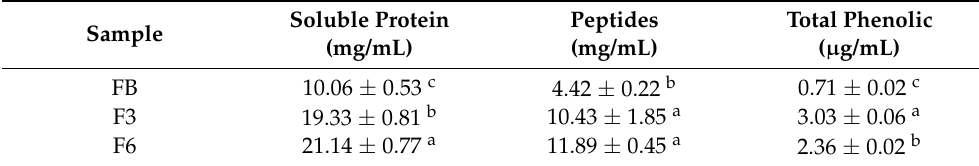
Table 1. Chemical composition analysis of FB, F3, and F6.